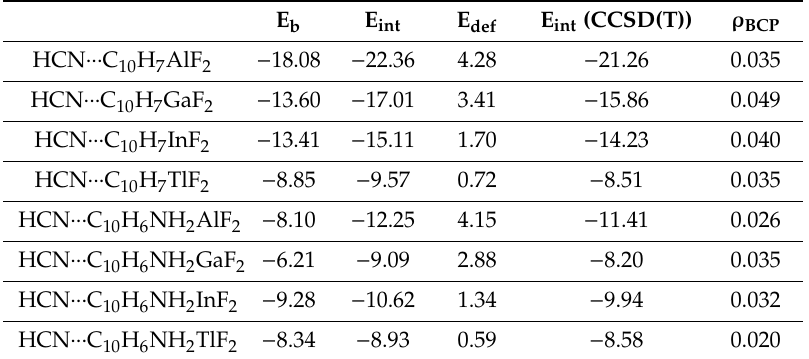
Table 5. Binding, interaction, and deformation energies (kcal / mol) and density at the Tr ··· N bond critical point (au) of naphthalene derivatives complexed with NCH corrected for basis set superposition error